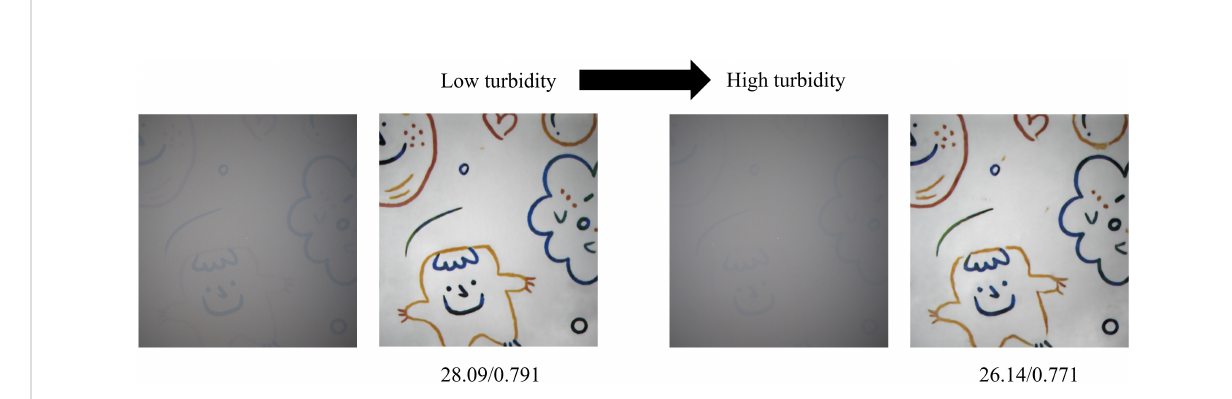
FIGURE 5 Results on low turbidity and high turbidity. Two evaluation metrics below the image represent PSNR (dB) and SSIM